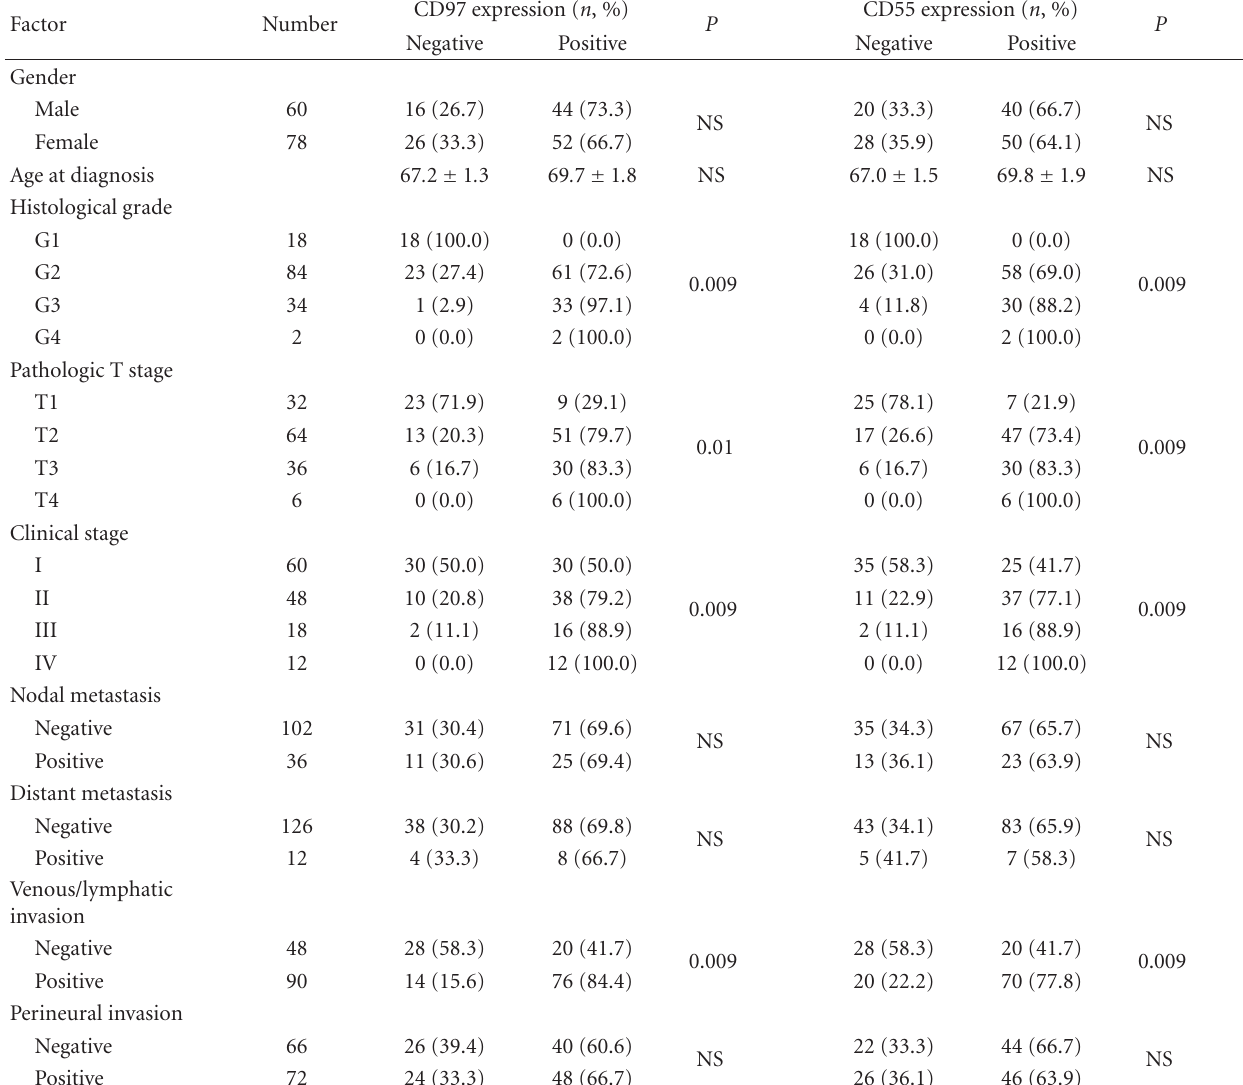
Table 1: Correlation of CD97 and CD55 expressions with conventional clinicopathological parameters in 138 patients with GBC.